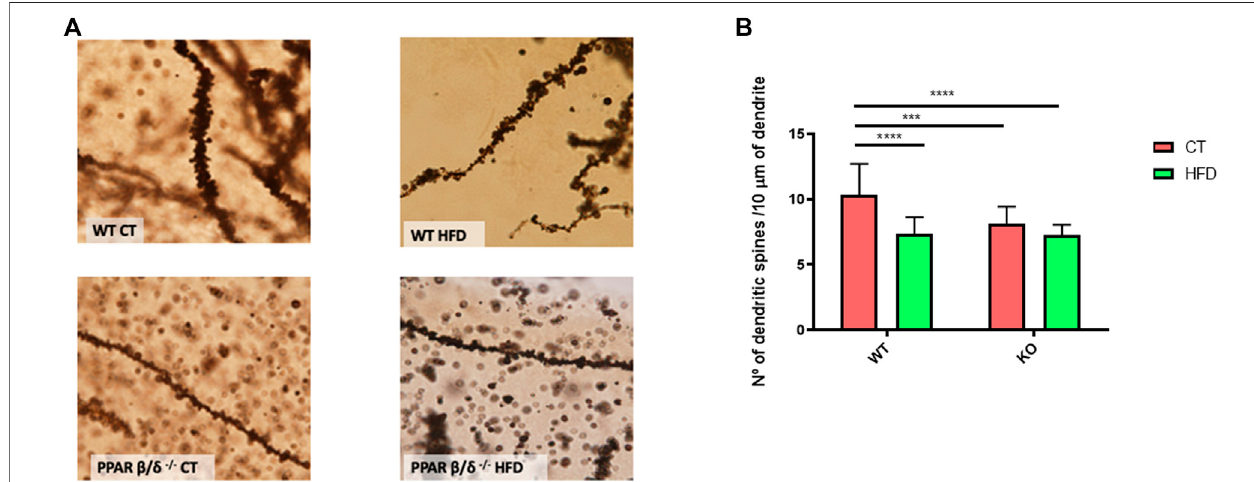
FIGURE3 |(A) Optical microscope images oftheDG ofhippocampus GolgiStain. Scale bar: 10 μ m. (B) Quanti fi cation of dendritic spines foreach 10 μ m. Groups werecomparedagainsteachotherusingtwo-wayANOVAandTukeypost-test( n =5)(WTCTvs.WTHFD:****denote p < 0.0001;WTCTvs.PPAR β / δ -/- CT:***denote